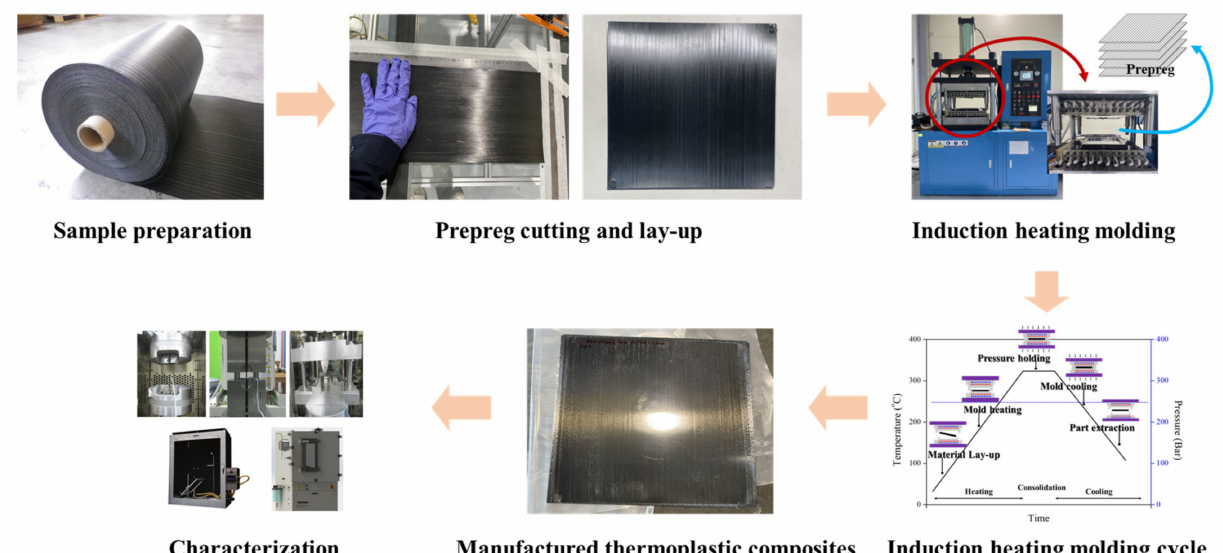
Figure 1. Schematic of the CF/PPS composites manufacturing process using induction-heating